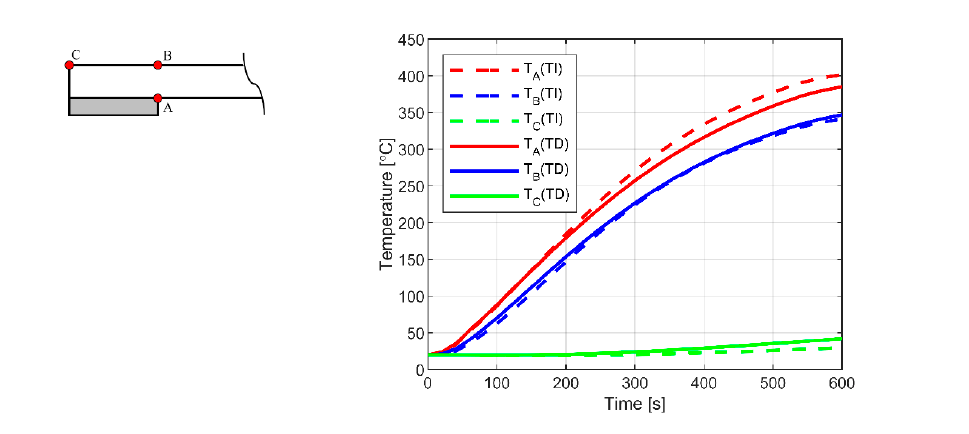
Figure 12. Temperature history (at selected control points) for 5 mm glass pane. Notation: TI— temperature independent; TD—temperature dependent material properties (ABAQUS/Standard).